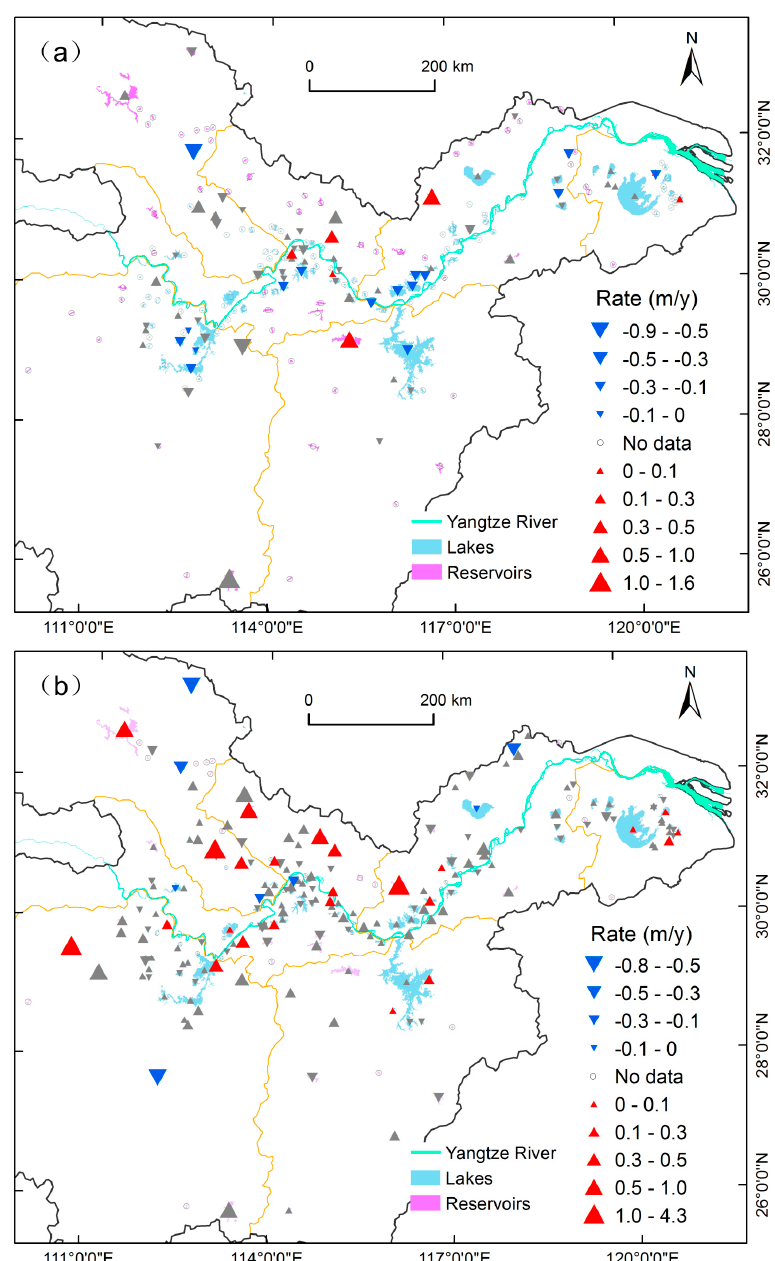
Figure 8. Spatial patterns of lake level change rates in the MLYB during ( a ) 2002–2009 and ( b ) 2010–2017, respectively. Note that solid red and blue triangles indicate significant changes at the 90% confidence level while grey triangles indicate no significant changes at this level.